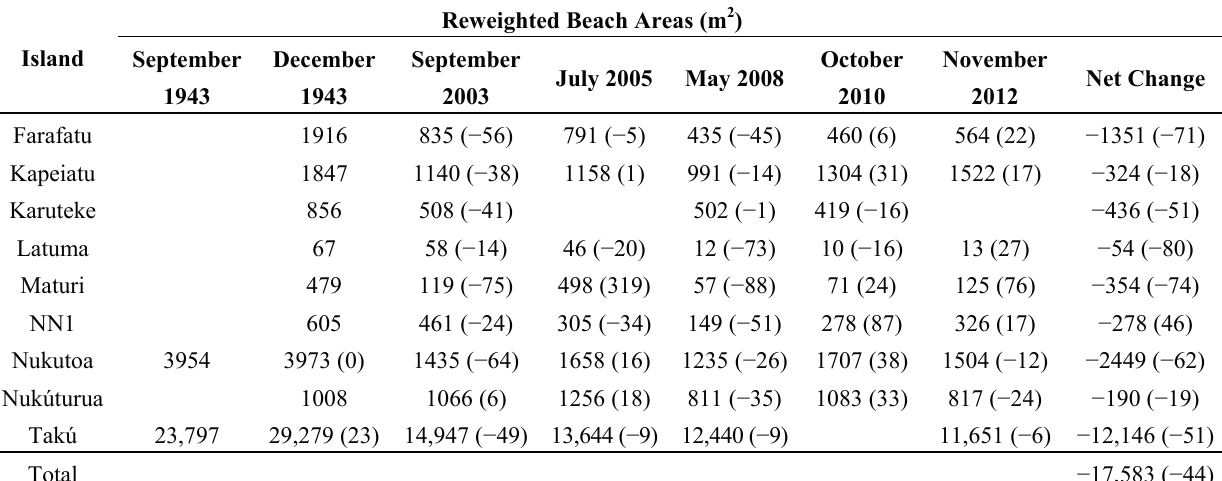
Table 3. Summary of changes in reweighted beach area for studied islands. Values in parantheses indicate percentage change of reweighted beach area compared to the chronologically preceding area. Net changes indicate changes in reweighted beach area for the maximum time period available.